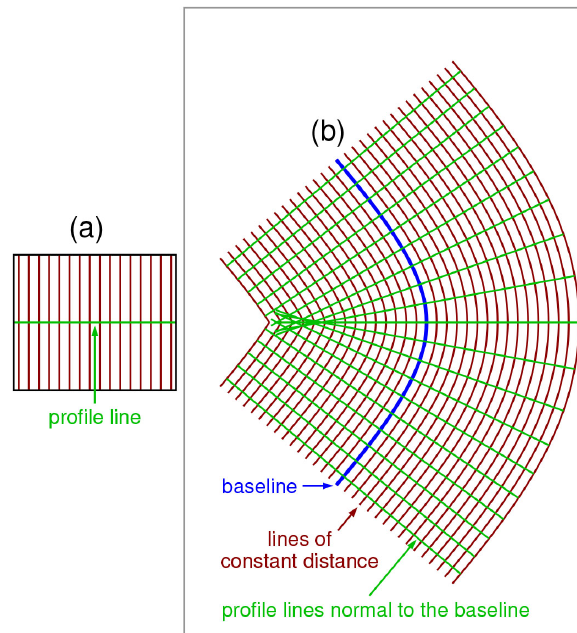
Figure 1. (a) Illustration of the idea of ordinary swath profiles. Green: profile line. Red: lines along which the elevation data are stacked. (b) Two ways of generalizing swath profiles towards curved baselines (blue). Green: profile lines normal to the baseline which might be stacked. Red: lines of constant signed distance from the baseline (the method proposed here). The gray frame defines the region of all points that potentially contribute to the profile as dis- cussed in Sect.